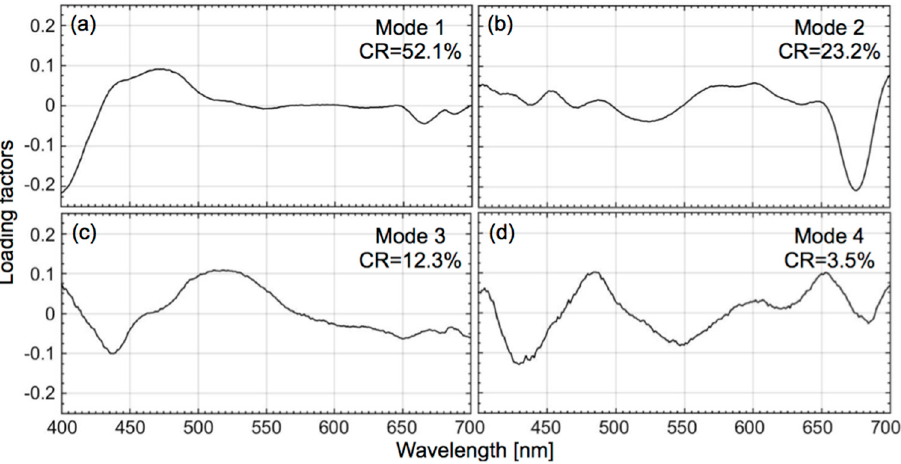
Figure 4. ( a – d ) Loading factors of first four modes derived from a std cumulative proportion of variance for each Figure 4. Loading factors of first four modes derived from (cid:1853) (cid:2926)(cid:2918)(cid:2929)(cid:2930)(cid:2914) ( λ ) spectra. CRs indicate cumulative proportion of variance for each mode.